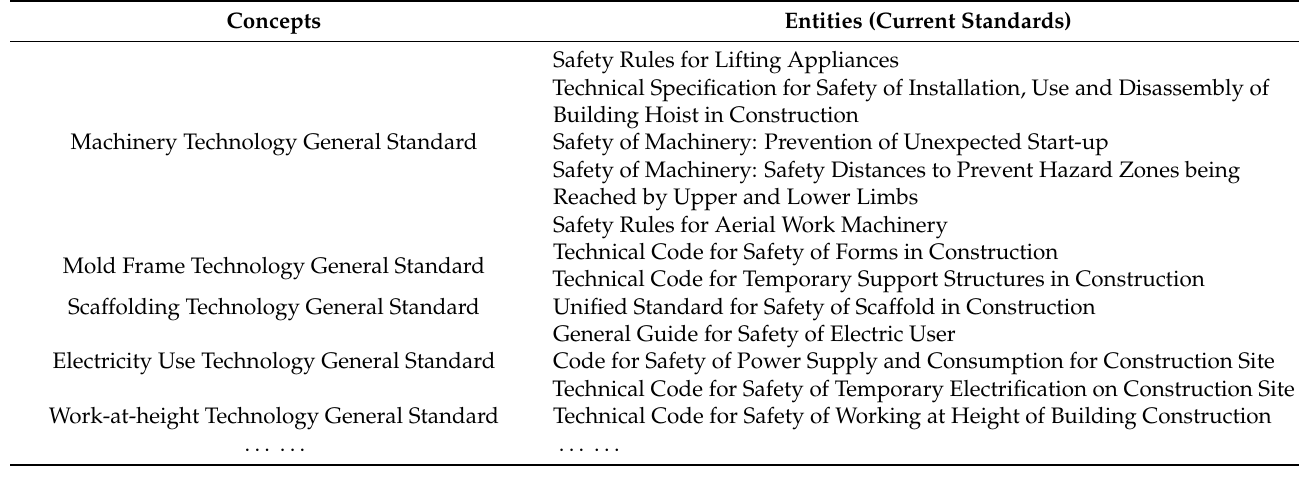
Figure 3. Construction logic of the entity layer of KGCSS. Table 2. Entities of construction safety standard knowledge graph